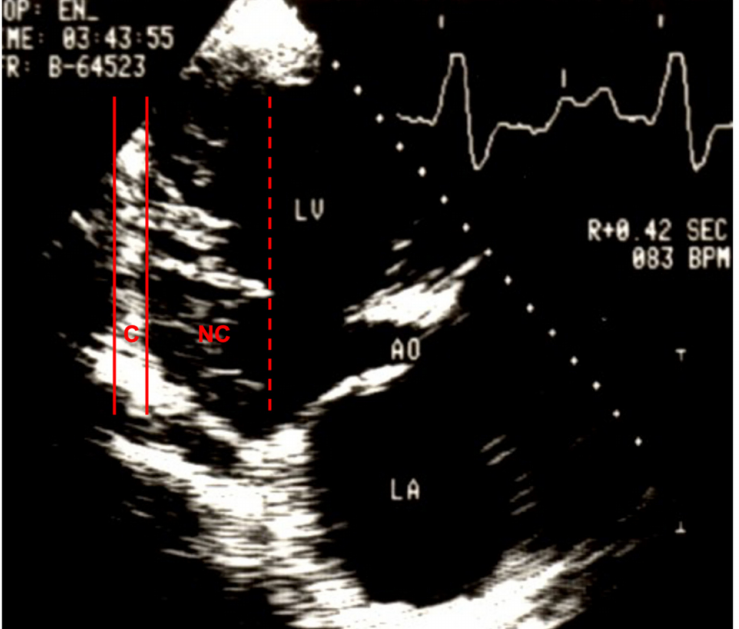
Figure 1. Echocardiography of the first published patient with NCCM without congenital heart disease. LV—left ventricle; LA—left atrium; Ao—aorta; C—compacted layer; NC—noncompacted layer of the left ventricular wall with deep recesses.